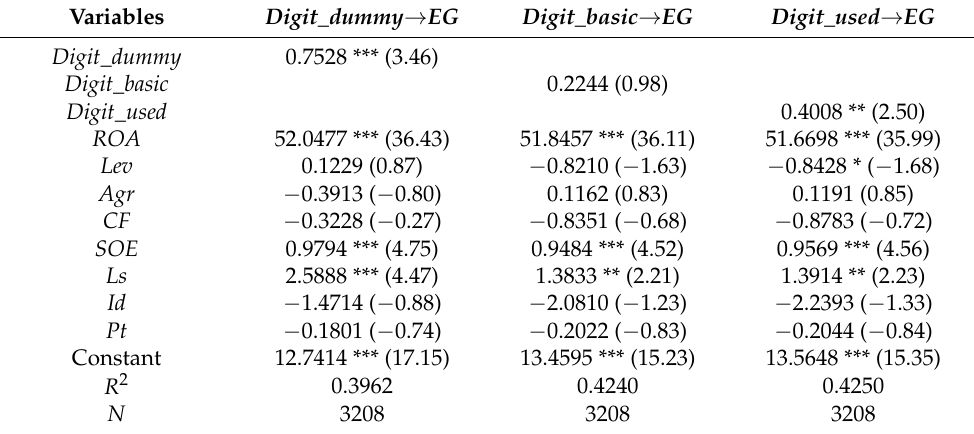
Table 6. Regression results of variable